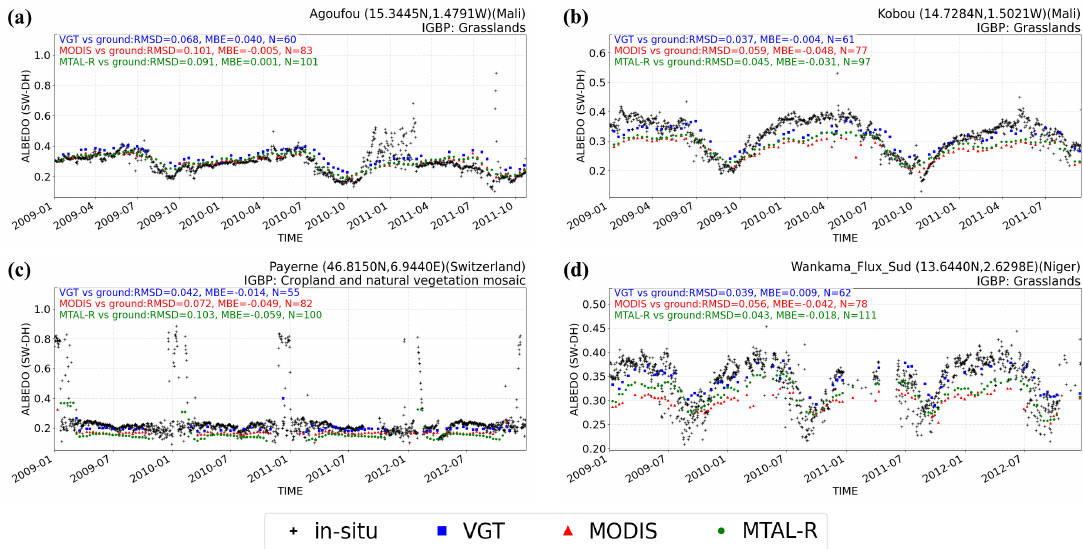
Figure A1. Time series of VGT (ten-daily) against ground measurements (daily) for a set of ground stations: ( a ) Agoufou; ( b ) Kobou; ( c ) Payerne; and ( d ) Wankama flux sud. All data are included. MODIS- and MTAL-R-derived equivalent albedo measurements are also presented. Difference statistics (root-mean-square deviation (RMSD) and mean bias error (MBE)) between satellite estimates and ground measurements are included. N is the number of satellite albedo estimates for which a ground measurement is available (thus, the number of estimates used to calculate the statistics).